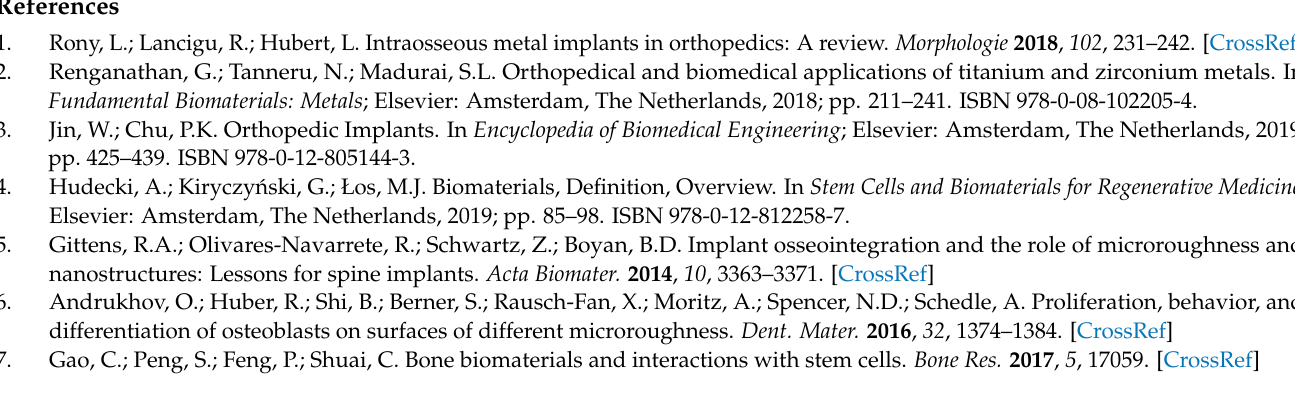
SBF. Table S2: Fitting parameters of impedance measurements of CaP/CS/CL coatings obtained by galvanic deposition during 3-weeks of aging in SBF